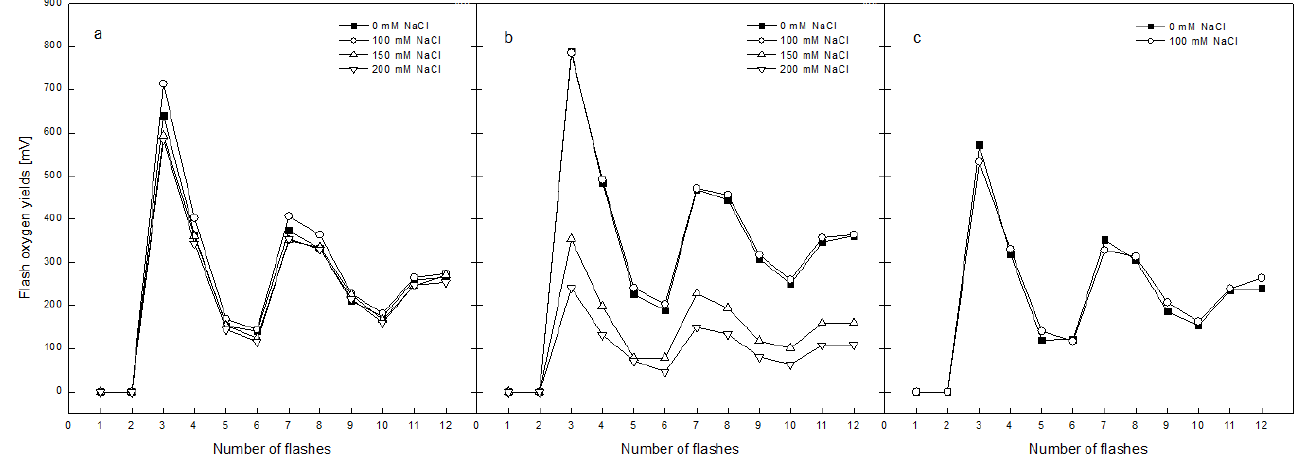
Figure 6. Effect of treatment with different concentrations NaCl (0, 100, 150 and 200 mM) on the flash oxygen yields of pea thylakoid membranes: ( a )–after 2 days of treatment, ( b )–after 5 days of treatment and ( c )–after recovery for 6 days on pure Hoagland’s solution. Mean values ± SE were calculated based on three independent experiments with two parallel samples for every time point ( n = 6). The flash oxygen yields were calculated using software based on the fitting of the experimentally obtained values to the theoretically calculated oxygen burst yields according to the non-cooperative Kok’s model.